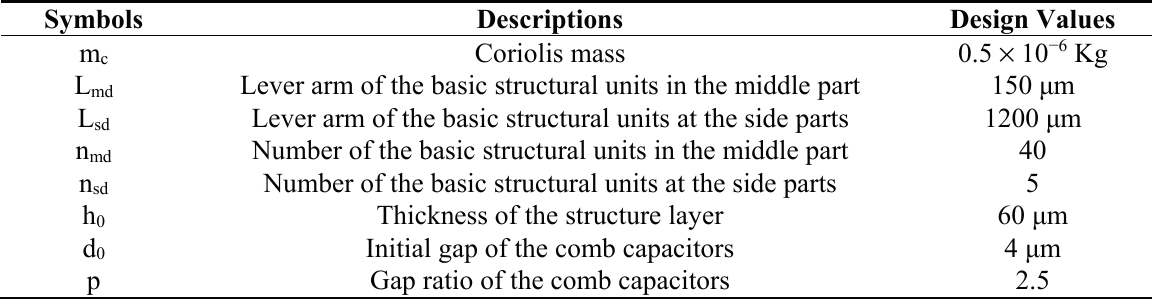
Table 1. Design parameters of the dual-mass silicon micro-gyroscope with quadrature compensation